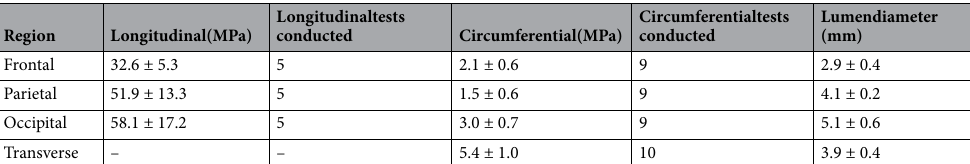
Table 1. E stiff values for both the longitudinal and circumferential test directions, along with the number of tests conducted per region and testing direction. Note that while 10 tests were conducted for the transverse region in the circumferential direction, 1 test was discarded due to hardware issues. Also shown are the lumen diameter values for the various regions. Data are represented as a mean ± standard error about the mean.